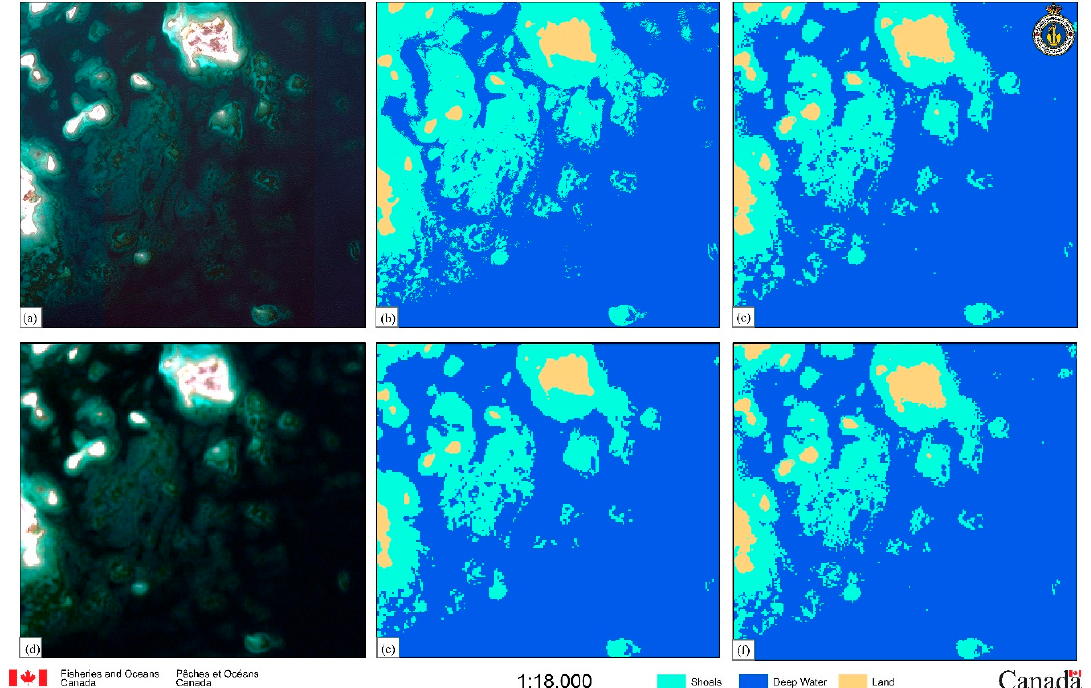
Figure 11. Automatic detection results with ( a ) a WorldView-2 image of Study Site 2, ( b ) CNN deep learning WorldView-2 results, ( c ) RF machine learning WorldView-2 results, ( d ) a Sentinel-2 image of Study Site 2, ( e ) CNN deep learning Sentinel results, and ( f ) RF machine learning Sentinel results. © 2017, DigitalGlobe and 2018, Copernicus. Table 4. Study Site 2 results displaying the commission and omission errors of the shoals class and the overall accuracy for the three shoals, deep water, and land